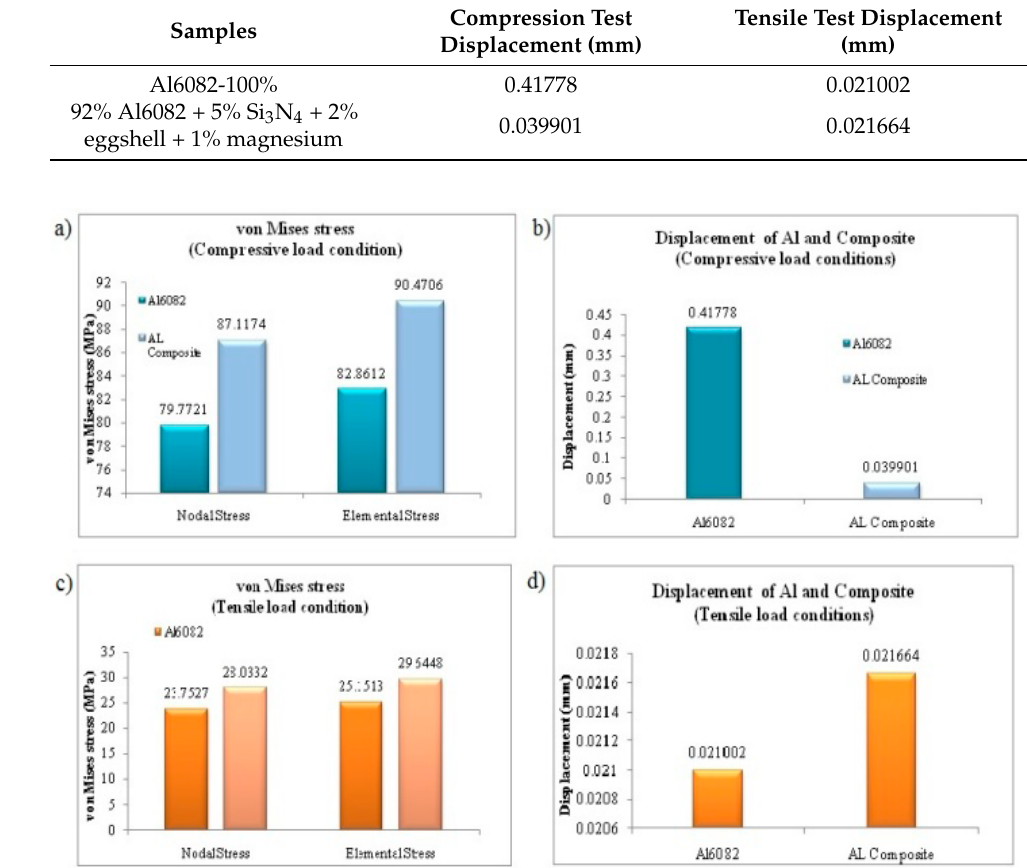
Figure 14. ( a ) Comparison of von Mises stress under compressive test, ( b ) displacement values of al and composite compressive load conditions, ( c ) nodal and elemental solution of von Mises stress under tensile load conditions, ( d ) comparison of nodal displacements under tensile load conditions.